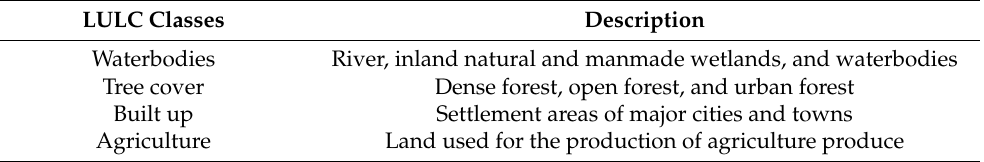
Table 2. Description of LULC classes.